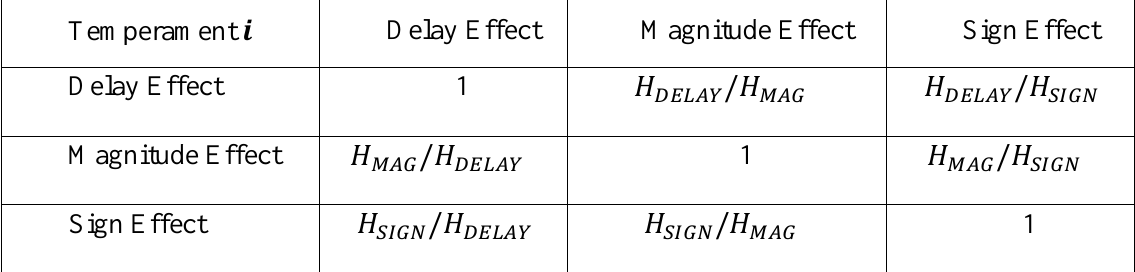
Table 6: Pairwise comparison matrices between temperaments i and anomalies.